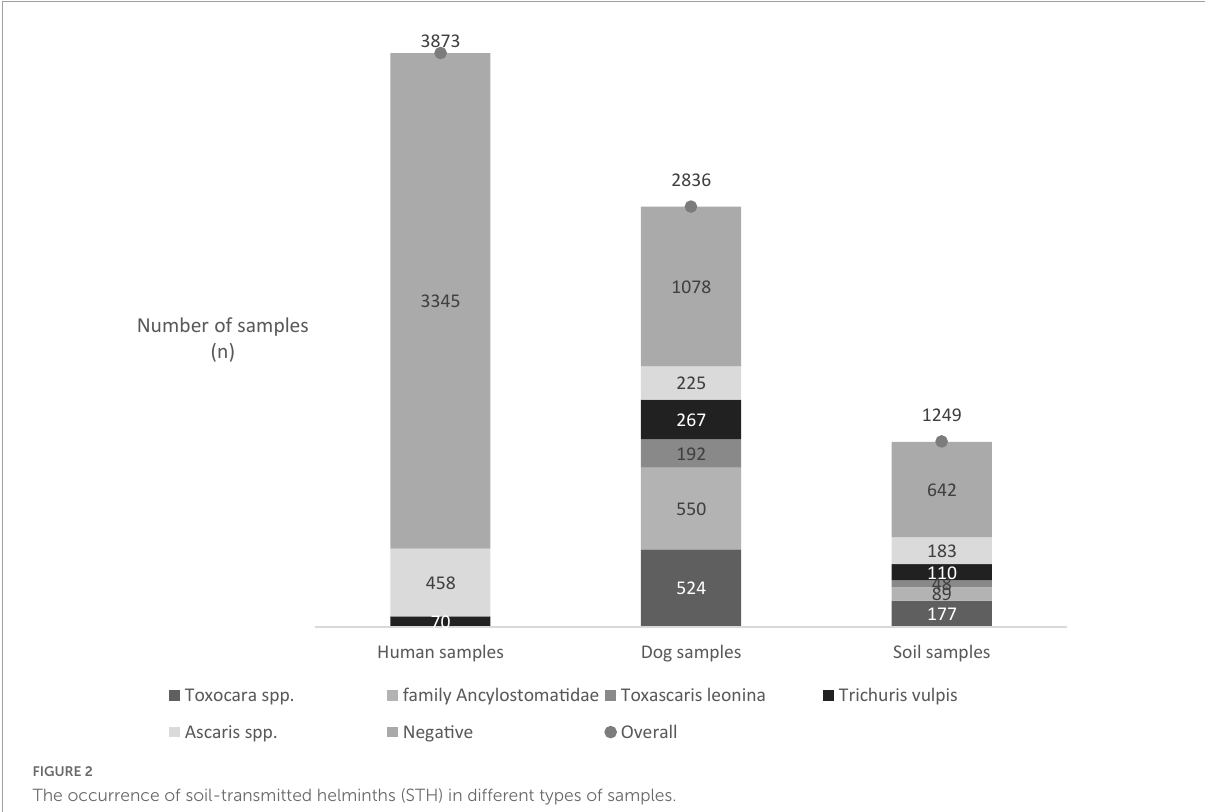
FIGURE2 The occurrence of soil-transmitted helminths (STH) in different types of samples.